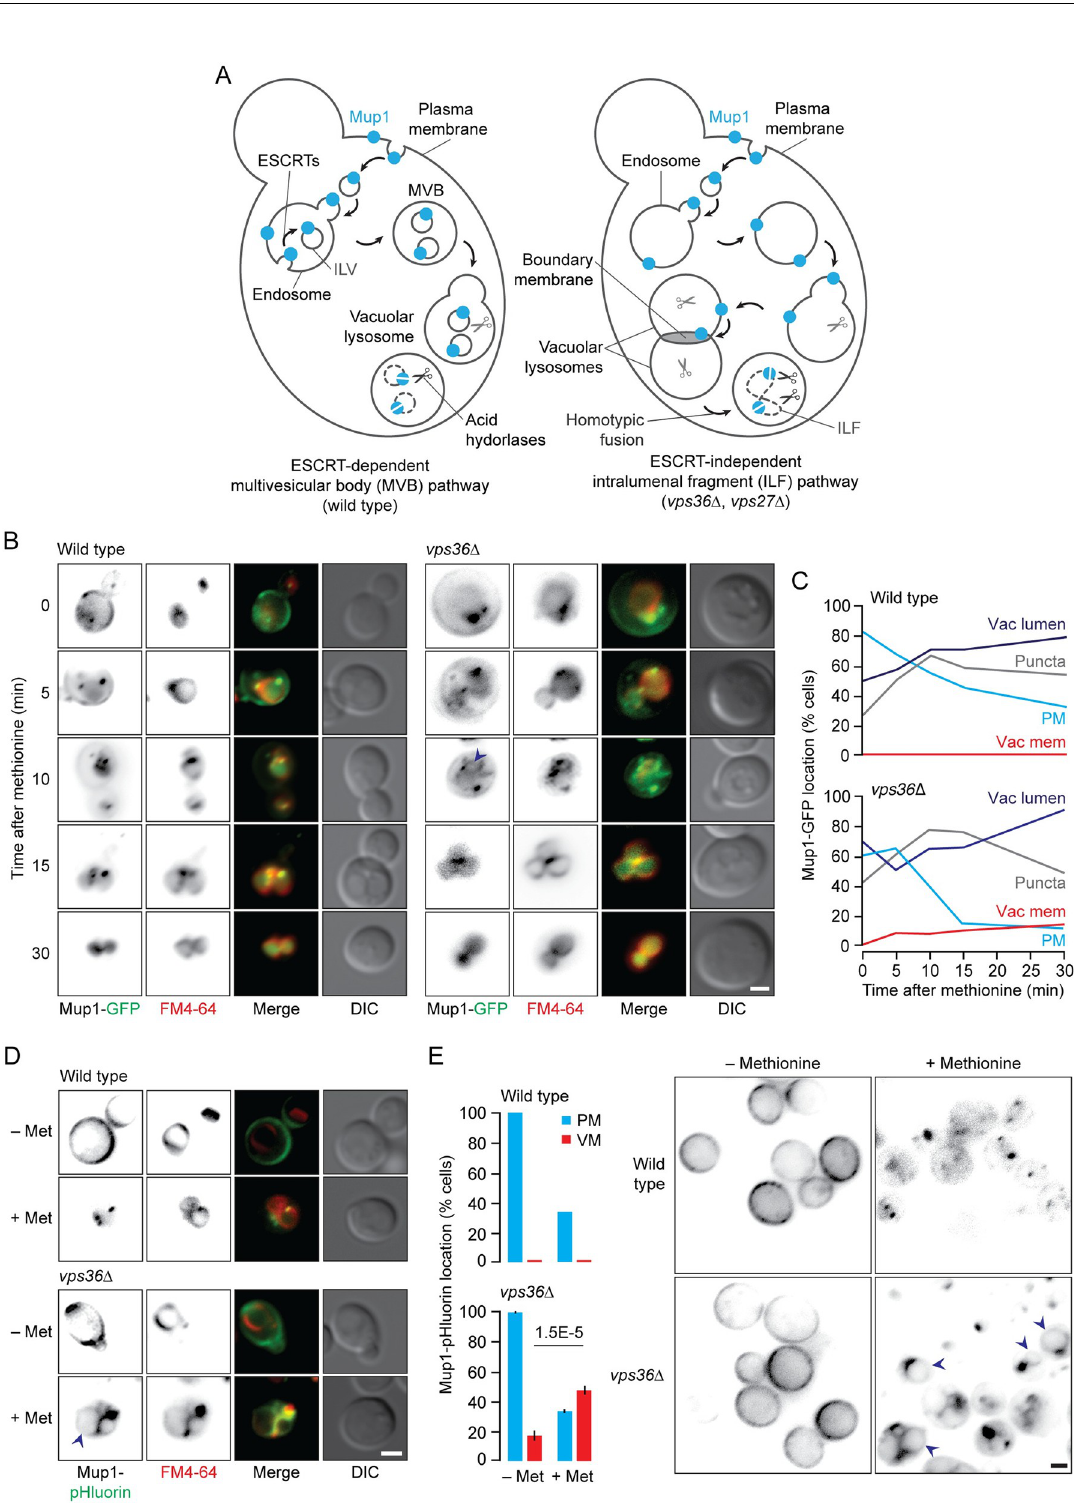
PLOS Genetics | https://doi.org/10.1371/journal.pgen.1010446 October 10, 2022 4 /